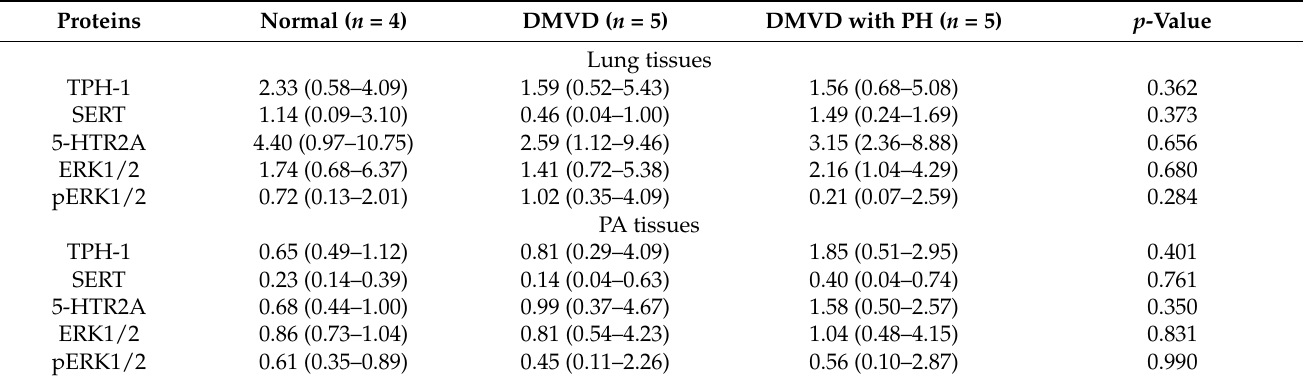
Table 5. The relative protein